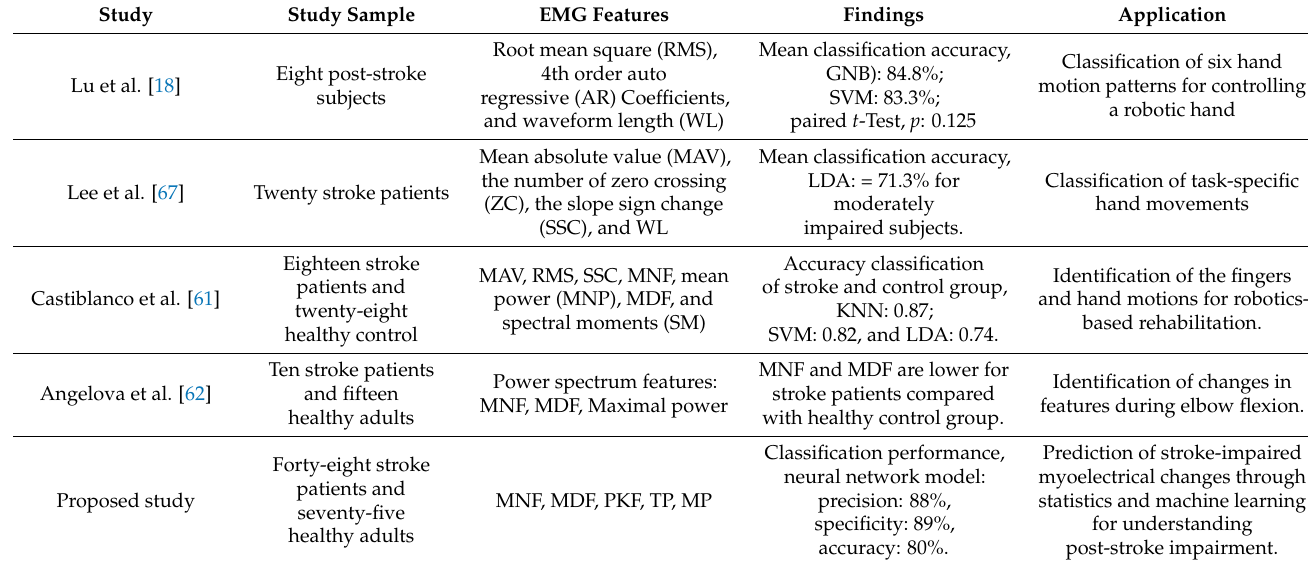
Table 4. Comparative study of methodologies and results between proposed study and previous